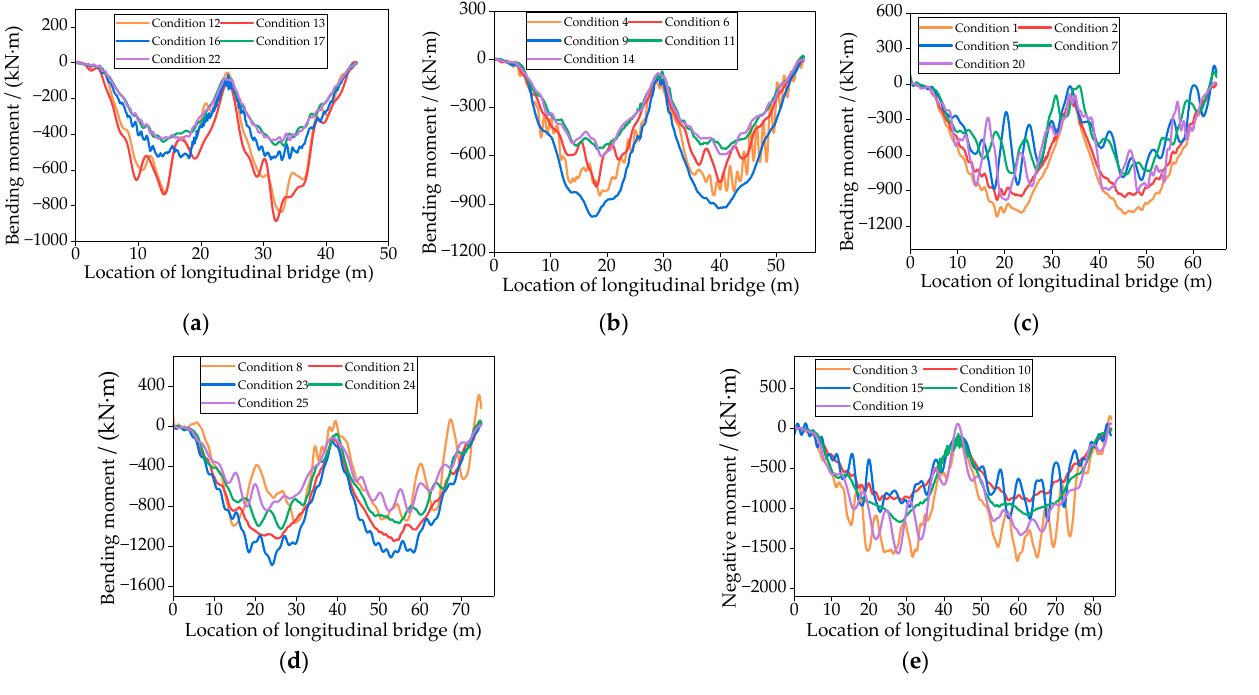
Figure 11. Time-history curves of the negative bending moment in the two-span continuous girder bridges. ( a ) Time-history curves of the bridges with a span of 20 m; ( b ) Time-history curves of the bridges with a span of 25 m; ( c ) Time-history curves of the bridges with a span of 30 m; ( d ) Time- history curves of the bridges with a span of 35 m; ( e ) Time-history curves of the bridges with a span of 40 m. Table 2. Parameters of each